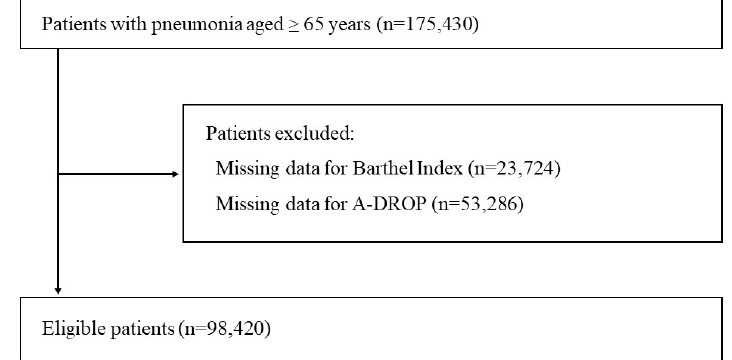
Figure 1. Overview of patient selection. Patients were categorized into low ‐ risk (72,207; 73.4%), intermediate ‐ risk (23,136; 23.5%), and high ‐ risk (3077; 3.1%) groups based on their HRFS. Table 1 shows the patient background data. Patients categorized into the high ‐ risk group were more likely to be female (55.9%), older than 90 years (38.3%), underweight (38.3%), and had a lower BI on admission (13.3 ± 26.4) than patients in the other frailty risk groups. Table 1. Patient characteristics. Low ‐ Risk Group (Hospital Frailty Risk Score < 5)